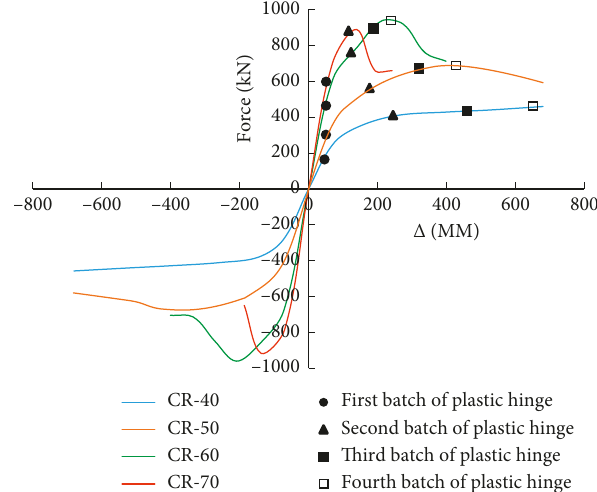
Figure 17: Development of plastic hinge.